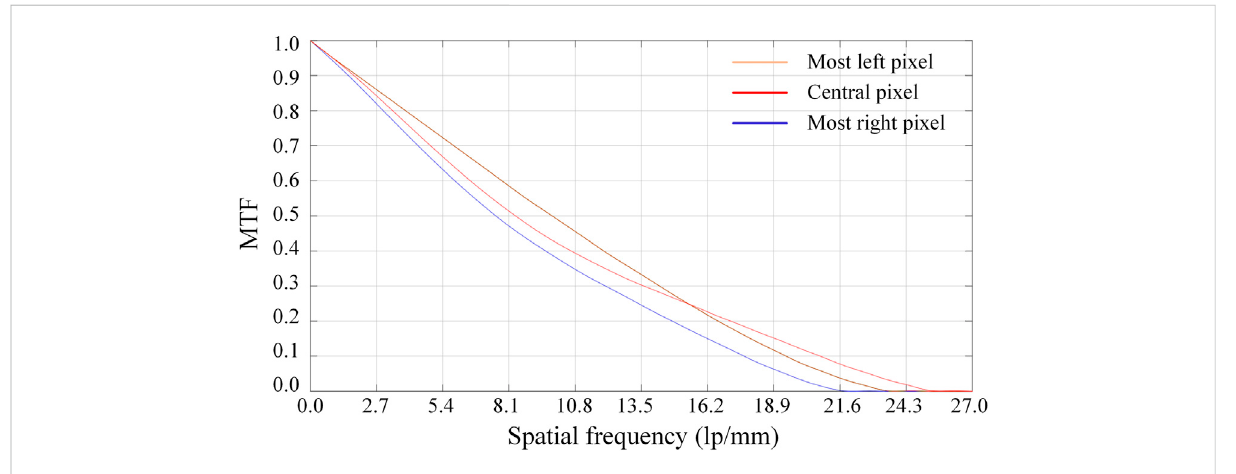
FIGURE 6 The MTF simulation results of optical imaging